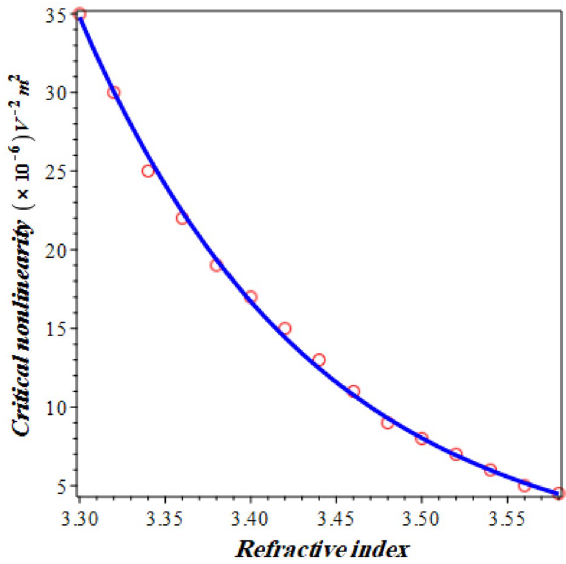
Figure 5. Critical nonlinearity coefficient as a function of the linear part of the delta stack refractive index.